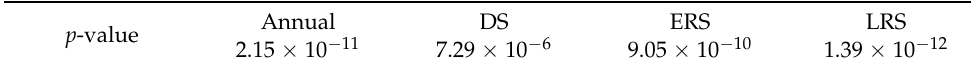
Table 3. List of p -values for regional (spatial) averaged SST